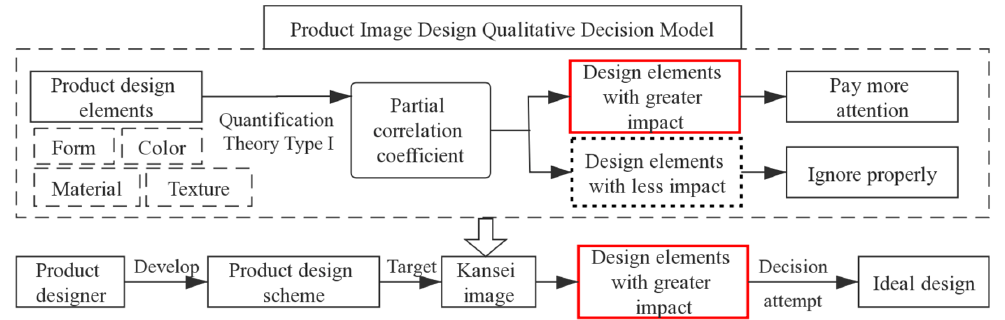
Figure 5. The qualitative decision model of product image design.